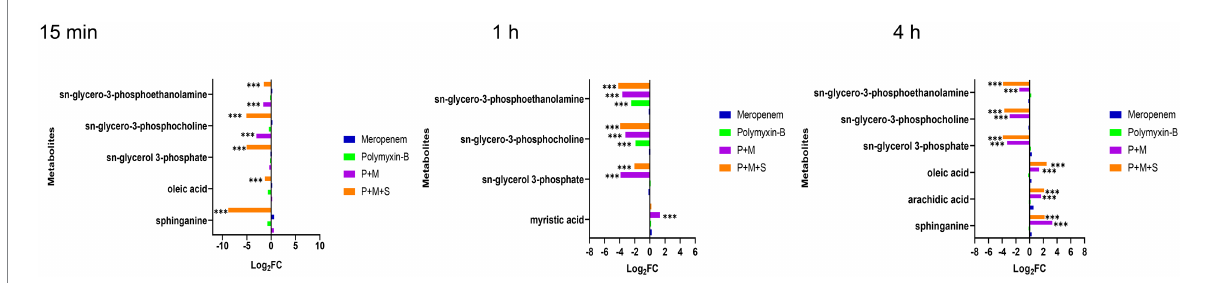
FIGURE 1 Perturbations of lipid metabolism pathways against Acinetobacter baumannii isolate treated with antibiotics as monotherapy and combination therapy at 15 min, 1 h and 4 h. Significantly perturbed metabolites were selected based on log 2 FC ≤ − 1 or ≥ 1, p < 0.05 and VIP > 1; * p < 0.05; ** p < 0.01; *** p <